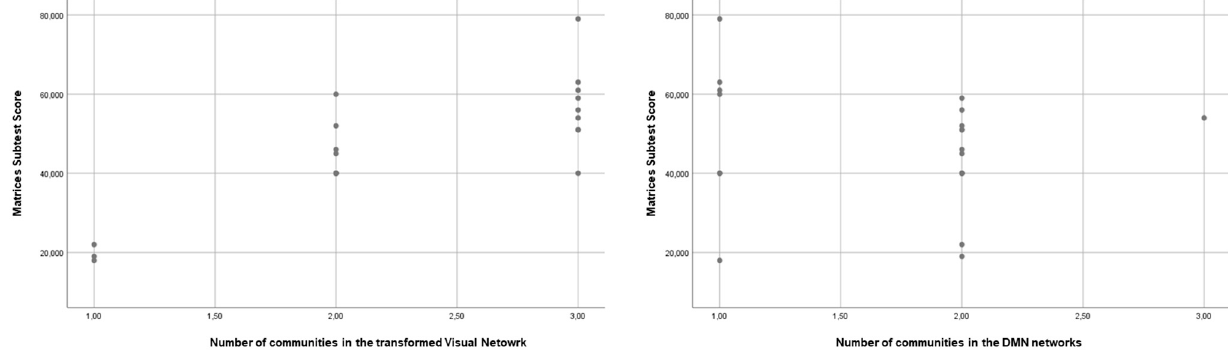
Figure 1. Bivariate plots representing the statistically significant effects of the linear model in predicting neuropsychological scores.